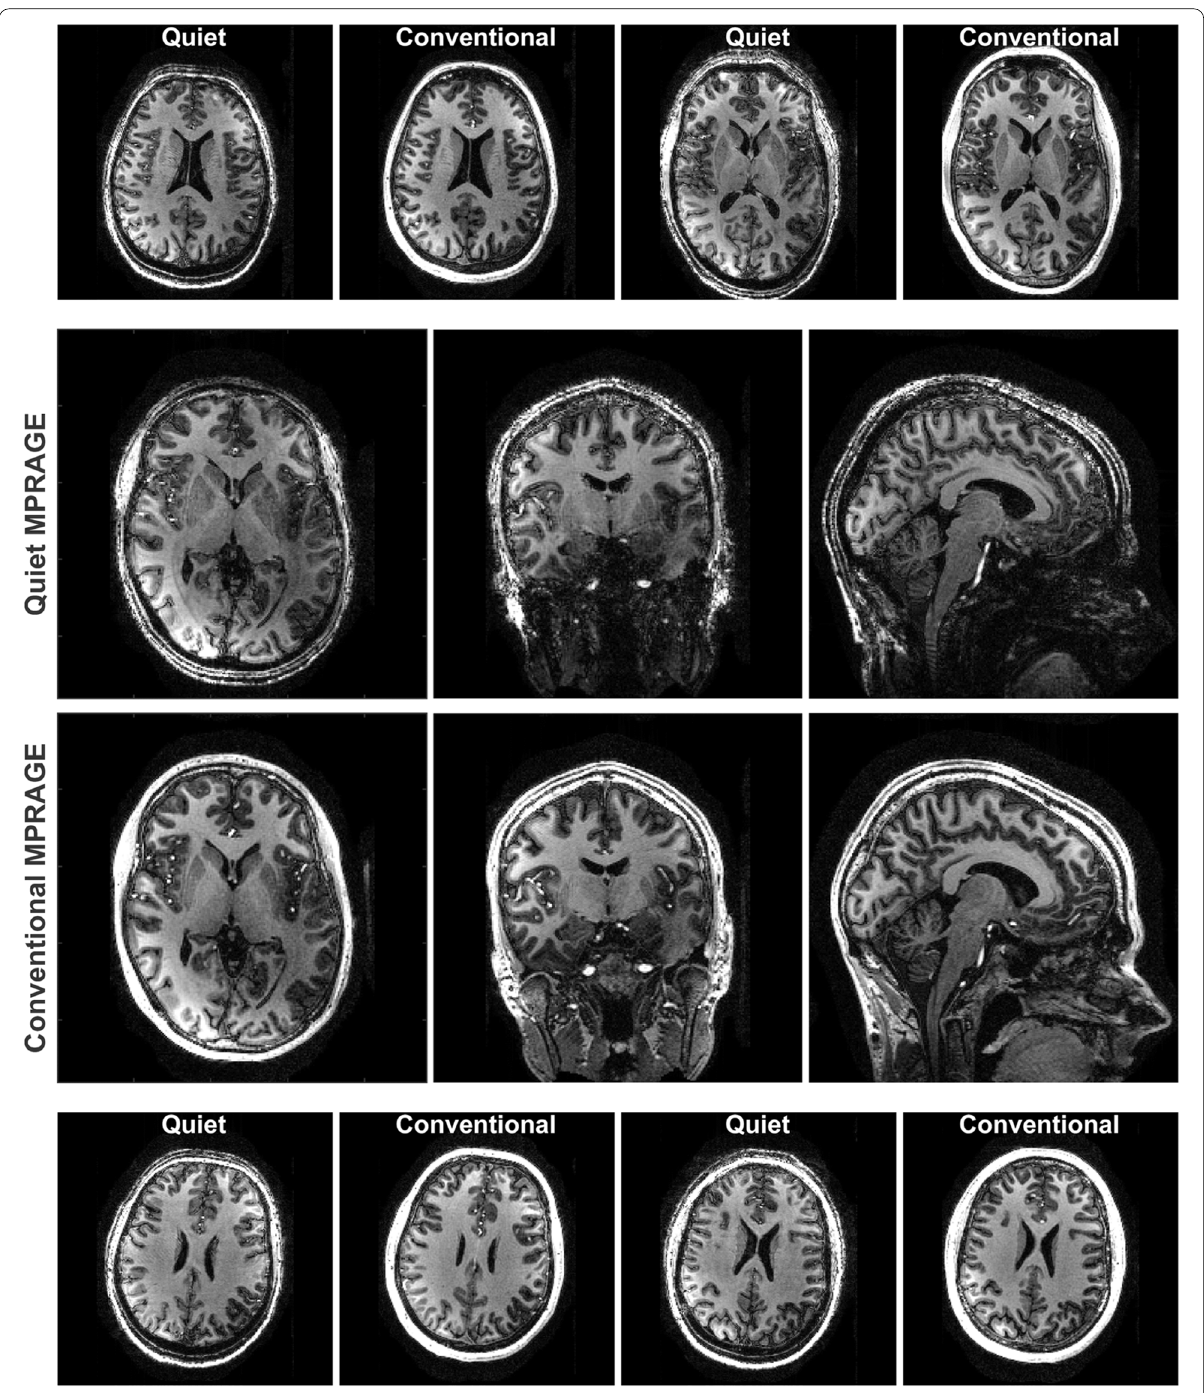
Fig. 3 Middle cross-sections of both sequences for a representative subject; top and bottom, axial slices of the other four